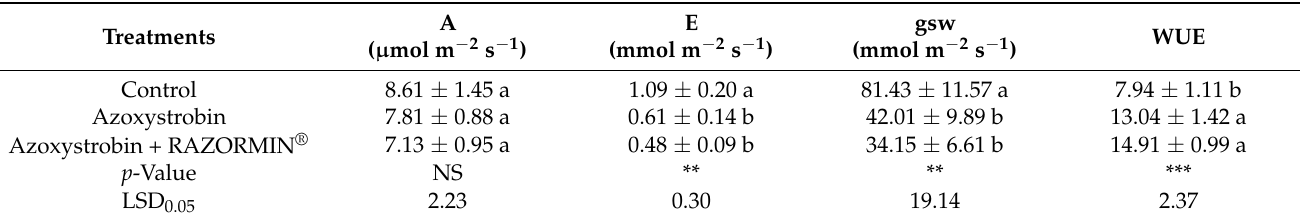
Table 9. Effect of the application of biostimulant RAZORMIN ® on photosynthetic efficiency in pepper plants subjected to the fungicide azoxystrobin.